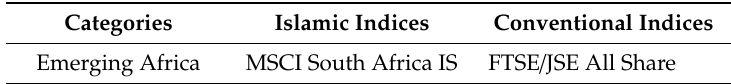
Table 3. The Africa Region’s Islamic and Conventional Stock Indices.